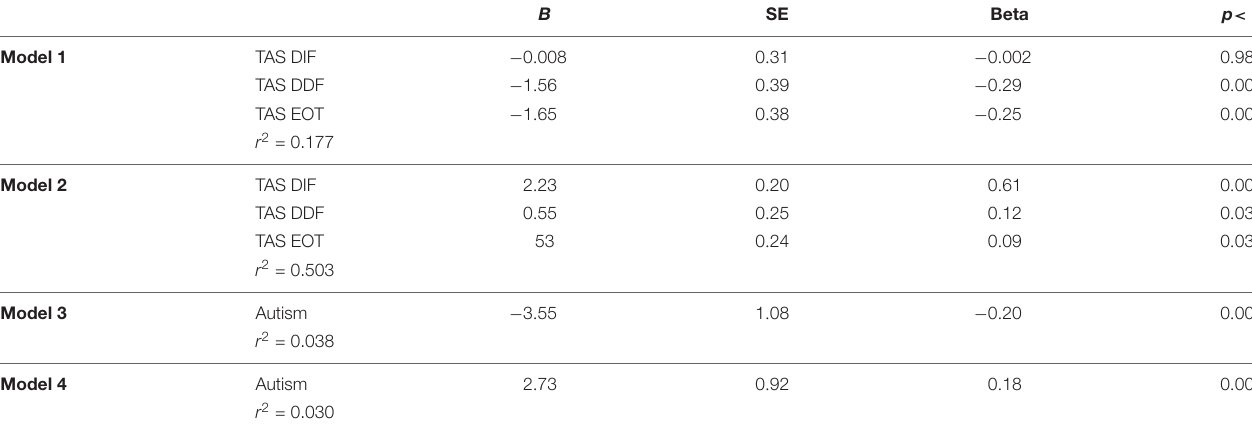
TABLE 2 | Regression coefficient for autistic and alexithymic traits, as predictors of social and emotional skills. B SE Beta p < Model 1 TAS